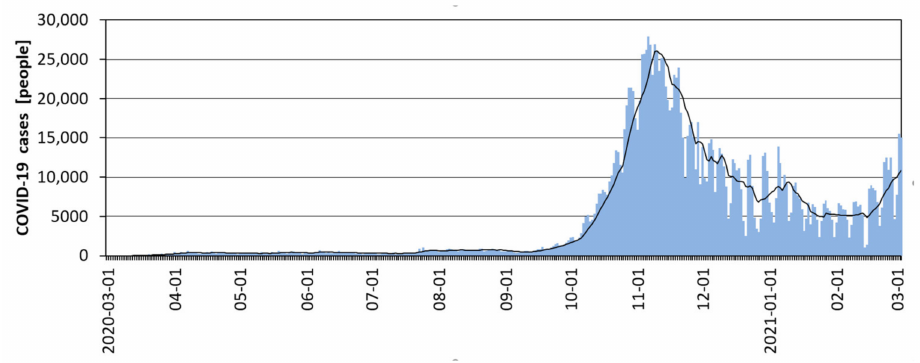
Figure 4. New daily COVID-19 cases in Poland, including the 7-day average, in March 2020–March 2021 (Source: [83]).